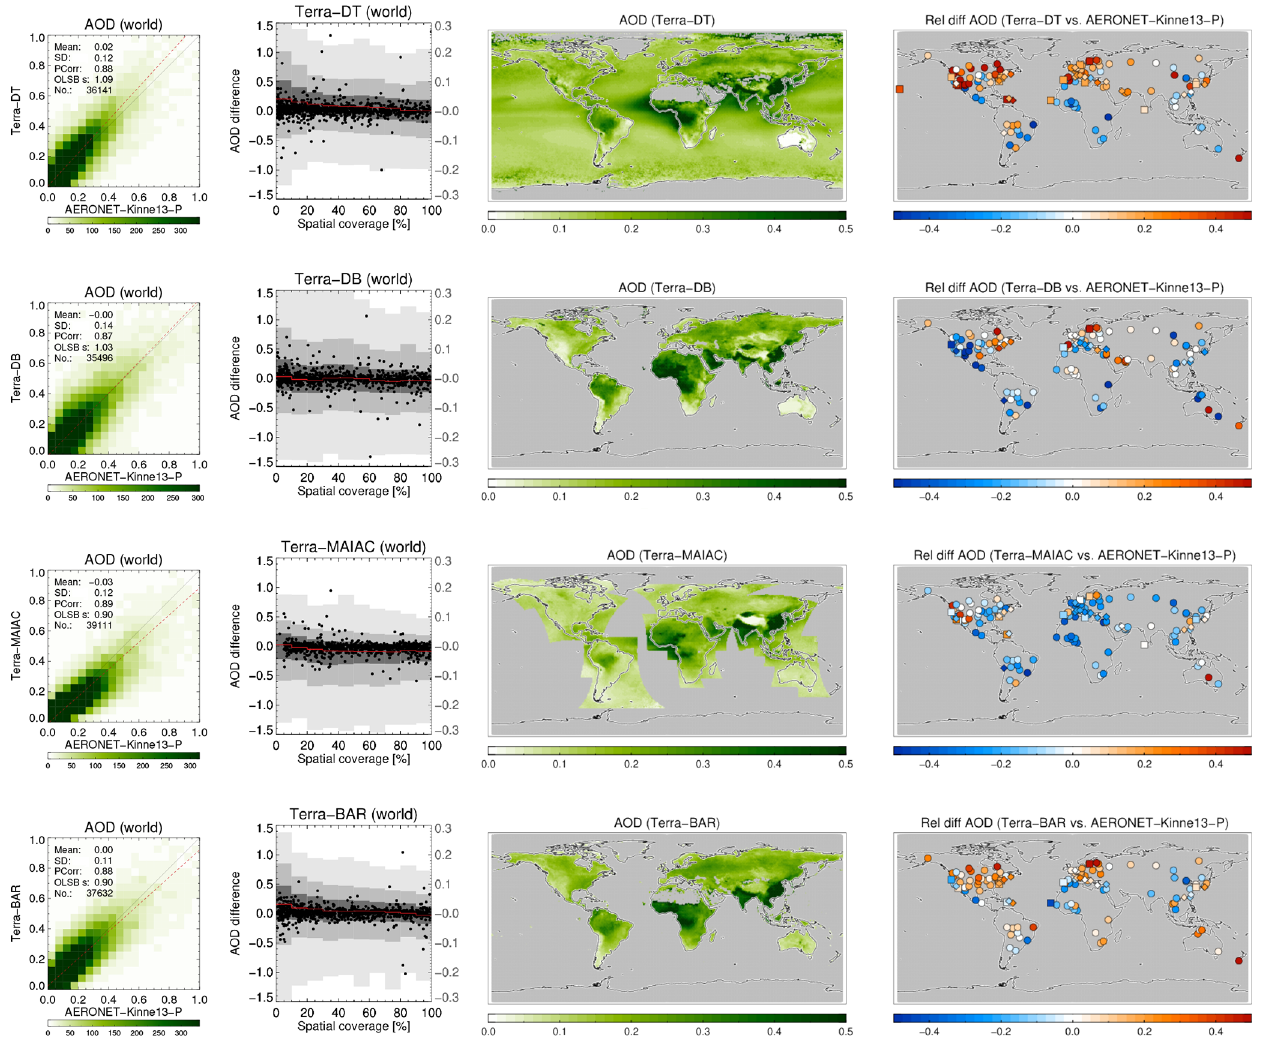
Figure 11. Same as Fig. 9, for MODIS-Terra